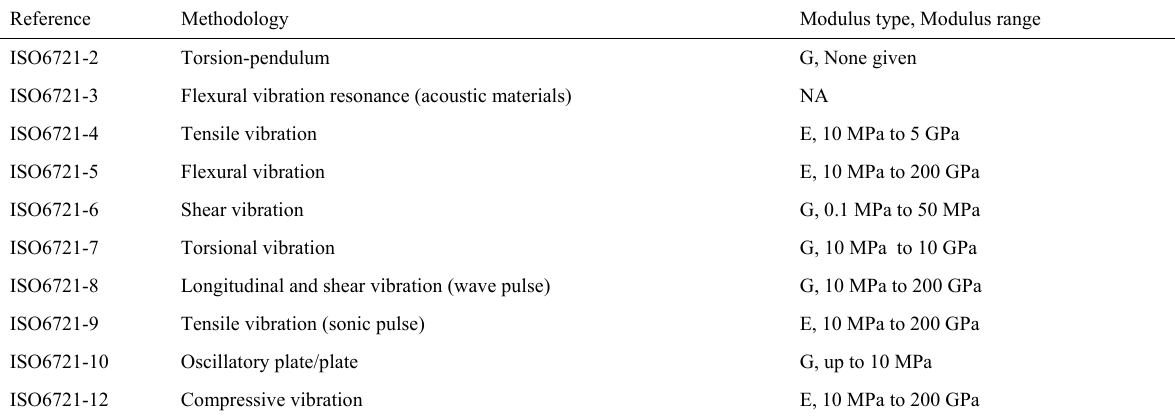
Table 1: Dynamic mechanical methods in ISO 6721 series